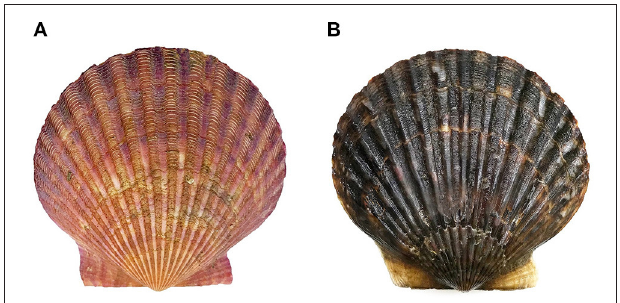
FIGURE 1 | (A) The purple-red shell color (PP) and (B) black-brown shell color (BP) bay scallops Argopecten irradians